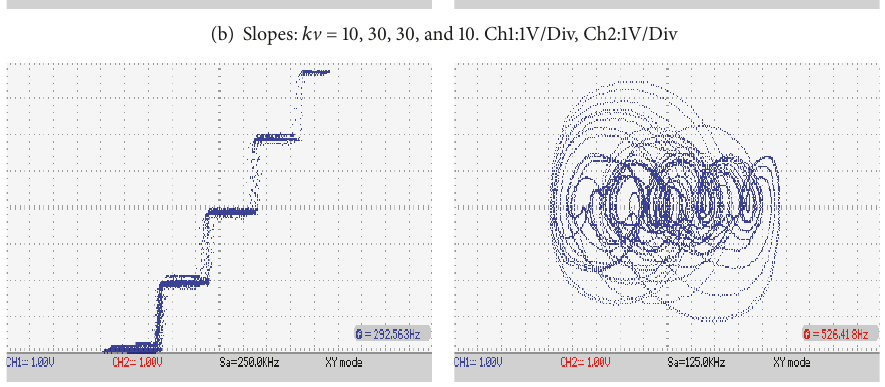
two cases are shown in Figures 9(b) and 9(c), respec-